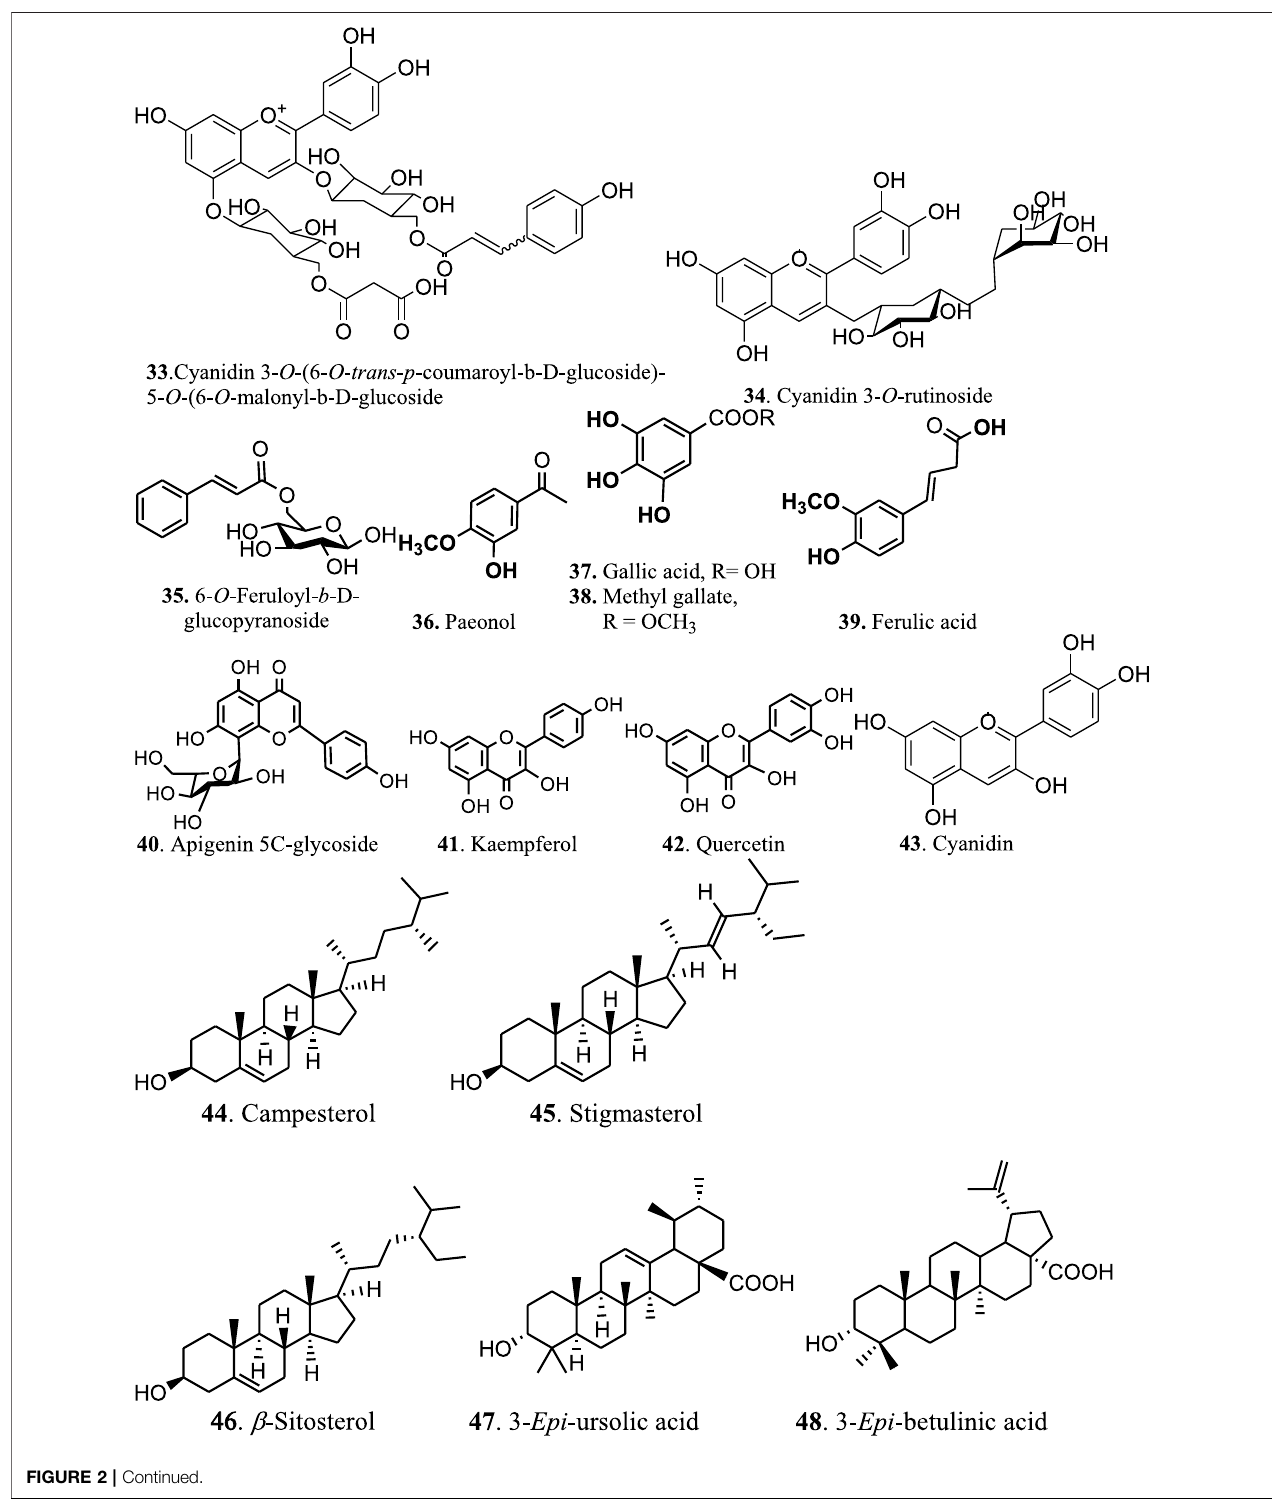
Anti-Cancer Activity Cancer is the leading cause of death worldwide, accounting for 7.4 million deaths, or approximately 13% of all deaths, in 2004 alone.